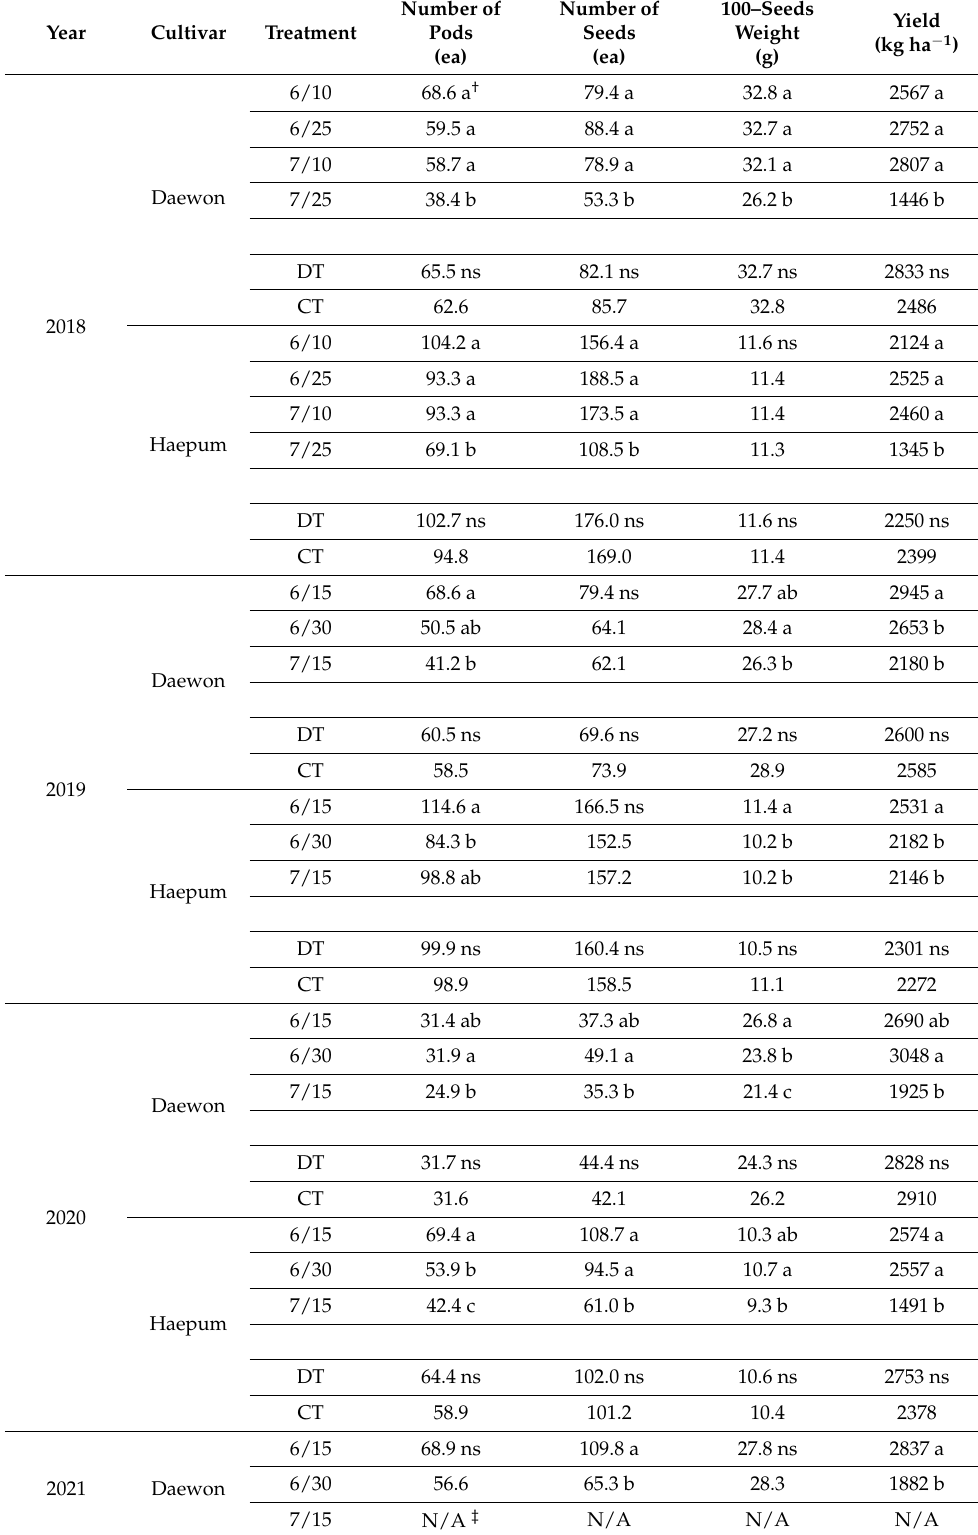
Table 12. Yield and yield components of two soybean cultivars (Daewon and Haepum), as influenced by the planting date and tillage practice (deep tillage, DT; conventional tillage,